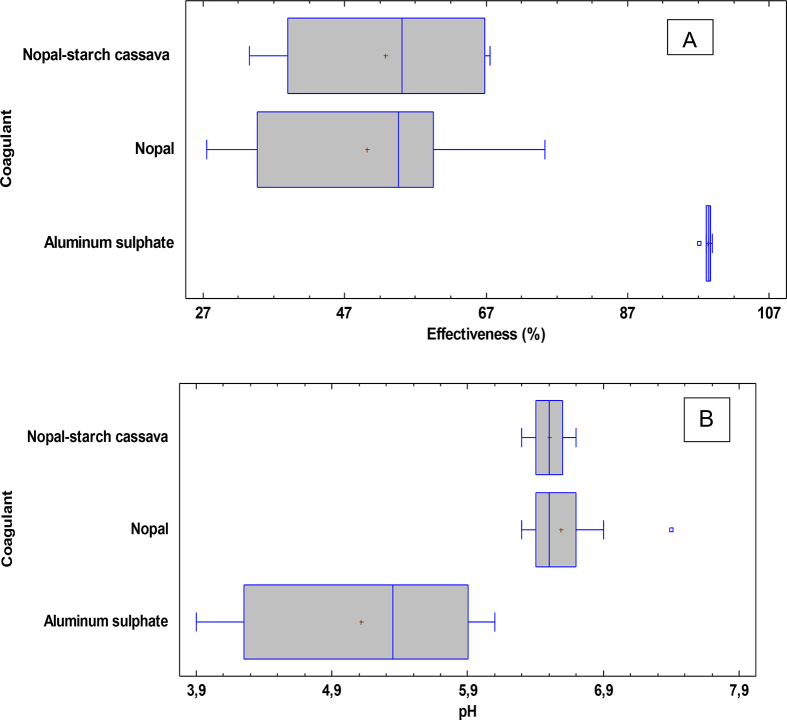
Boxplot of the parameters evaluated. A) Turbidity removal efficiency between coagulants. B) Variation of pH between coagulants.